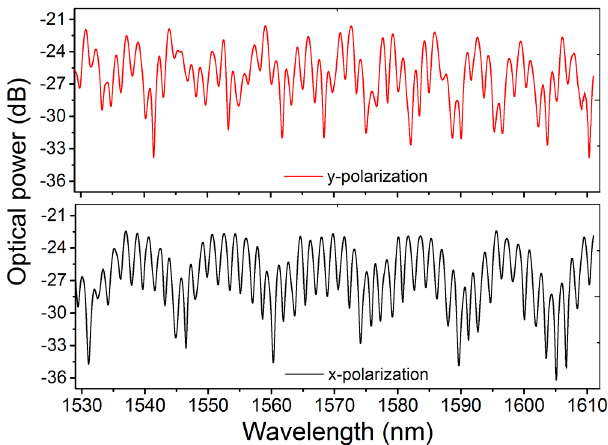
Figure 2. Transmission spectrum of the fiber m-MZI using highly birefringent ATC-PCF ( L ~ 3.6 cm) for two polarizations.